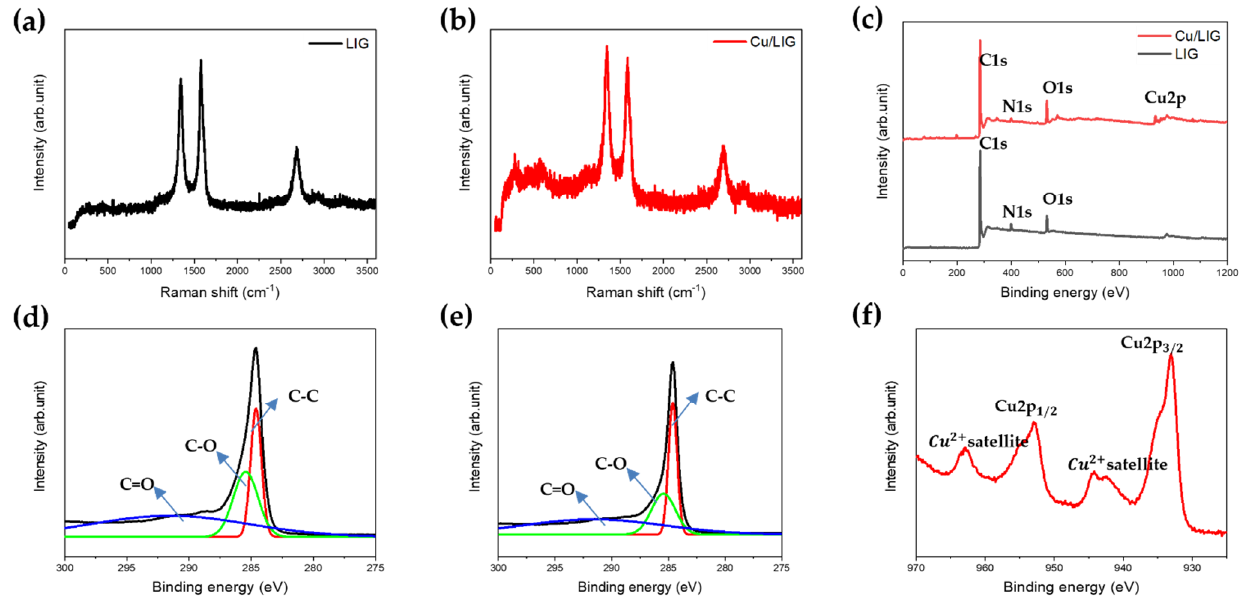
Figure 3. Raman spectra of ( a ) LIG and ( b ) Cu/LIG. ( c ) XPS characteristics of LIG and Cu/LIG, XPS C1s data of ( d ) LIG, ( e ) Cu/LIG, ( f ) XPS spectra for Cu 2p of Cu/LIG. If the (cid:1835) (cid:3034) / (cid:1835) (cid:2870)(cid:3005) ratio is greater than 1, then the graphene is multilayered. Because the